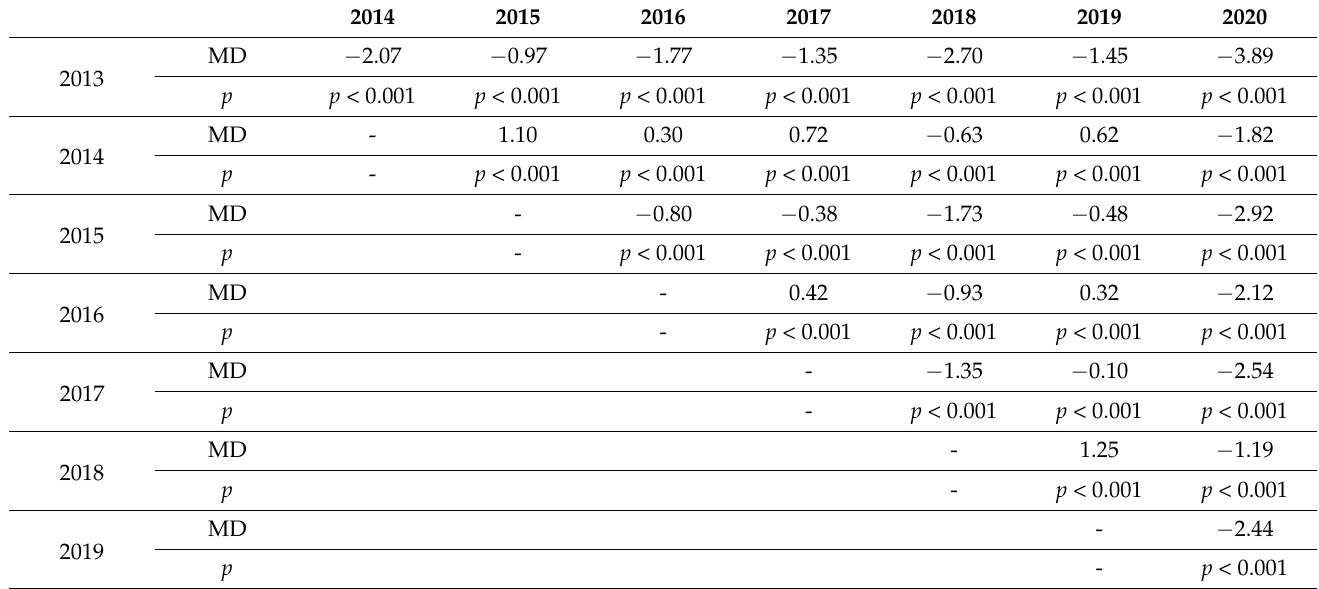
Table 8. Comparison of the energy use for defibrillation between individual editions of the Champi- onships.